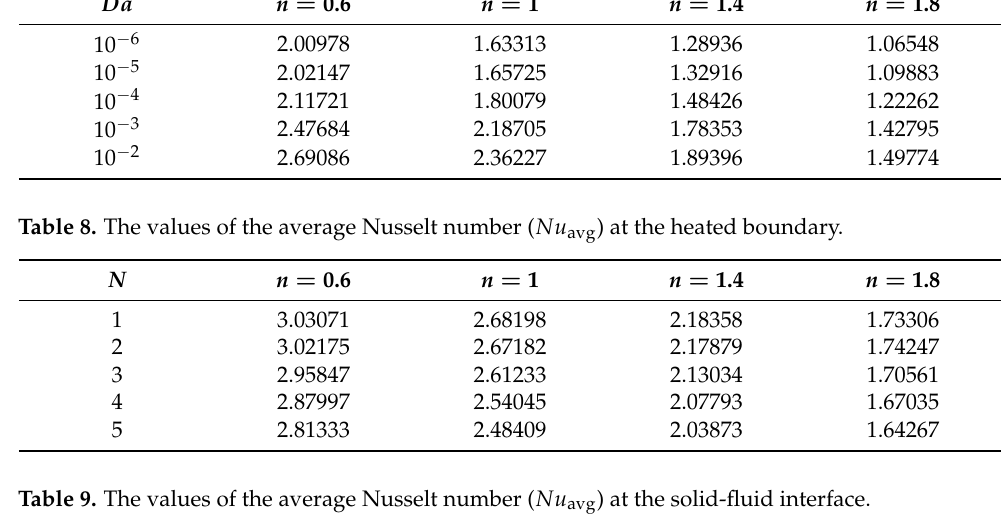
Table 7. The values of the average Nusselt number ( Nu avg ) at the solid-fluid interface. Da n = 0.6